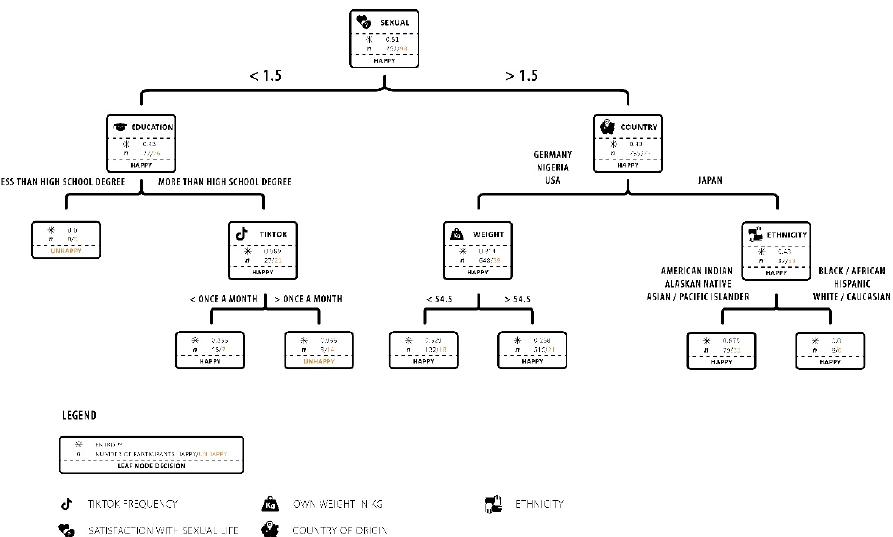
Figure 3. Factors influencing happiness with one’s own buttocks in women. A classification and regression tree (CART) describes the most important factors that influence the evaluation of happiness with one’s own buttocks (binary value: happy and unhappy). The CART depicts the splitting variables, the entropy, happy, unhappy and the number of survey participants. n = 963 female participants.